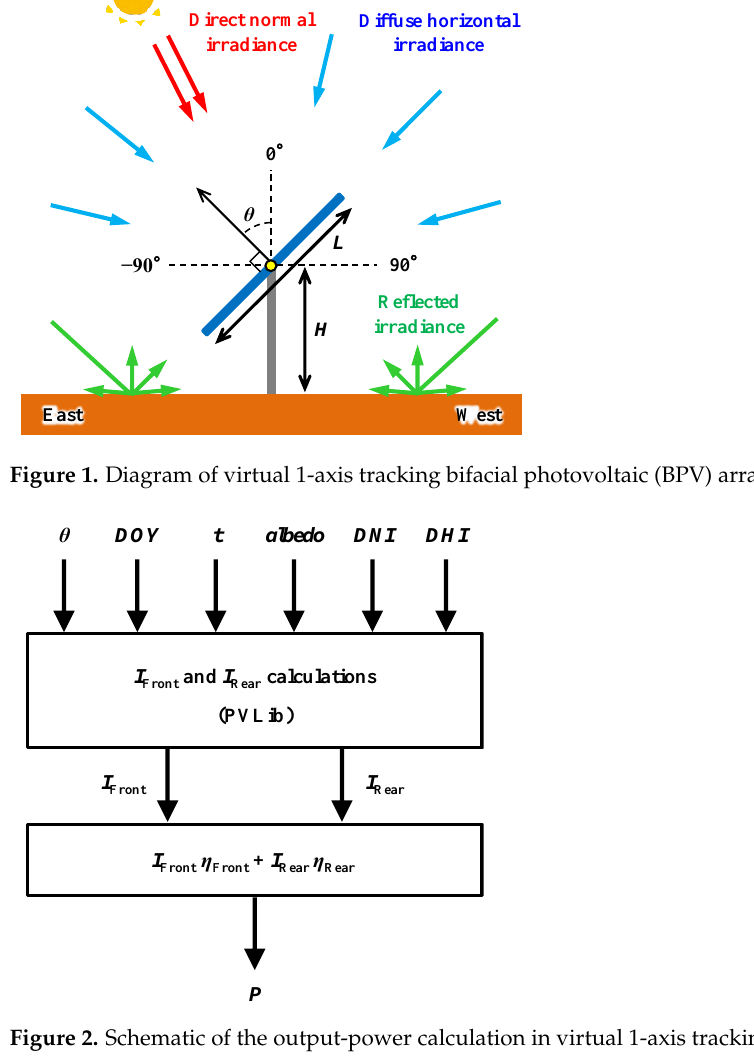
Figure 2. Schematic of the output-power calculation in virtual 1-axis tracking BPV array.